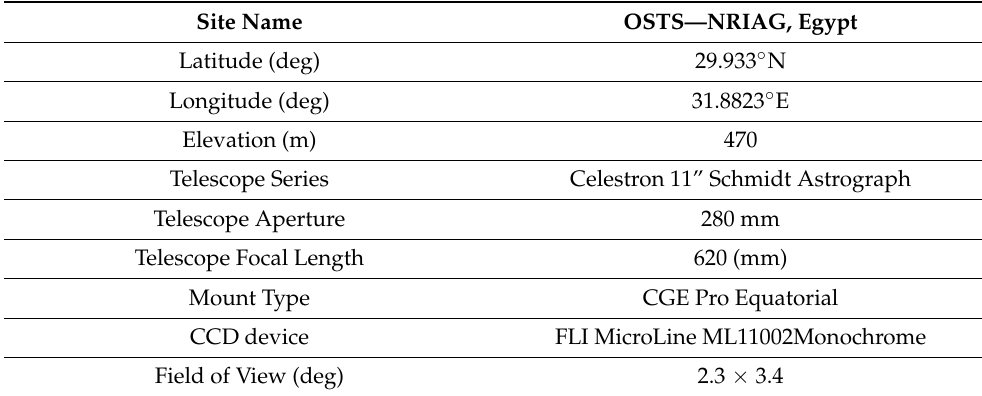
Figure 2. The OSTS station—NRIAG, Egypt. Table 1. The fundamentals of the optical Satellite Tracking Station (OSTS).